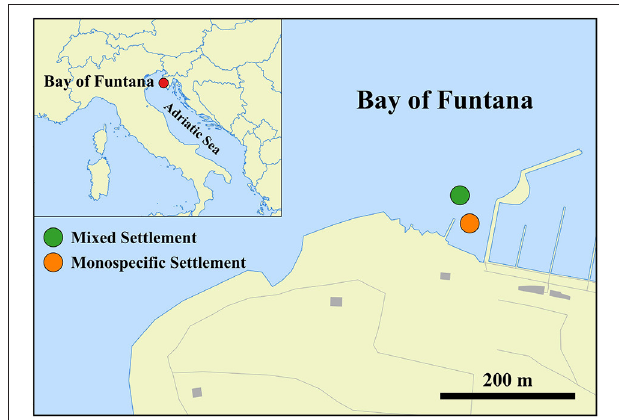
FIGURE 1 | Location of the mixed ( C. nodosa and C. cylindracea ) and monospecific ( C. cylindracea ) settlement in the Bay of Funtana, northern Adriatic Sea (© OpenStreetMap contributors, www.openstreetmap.org/